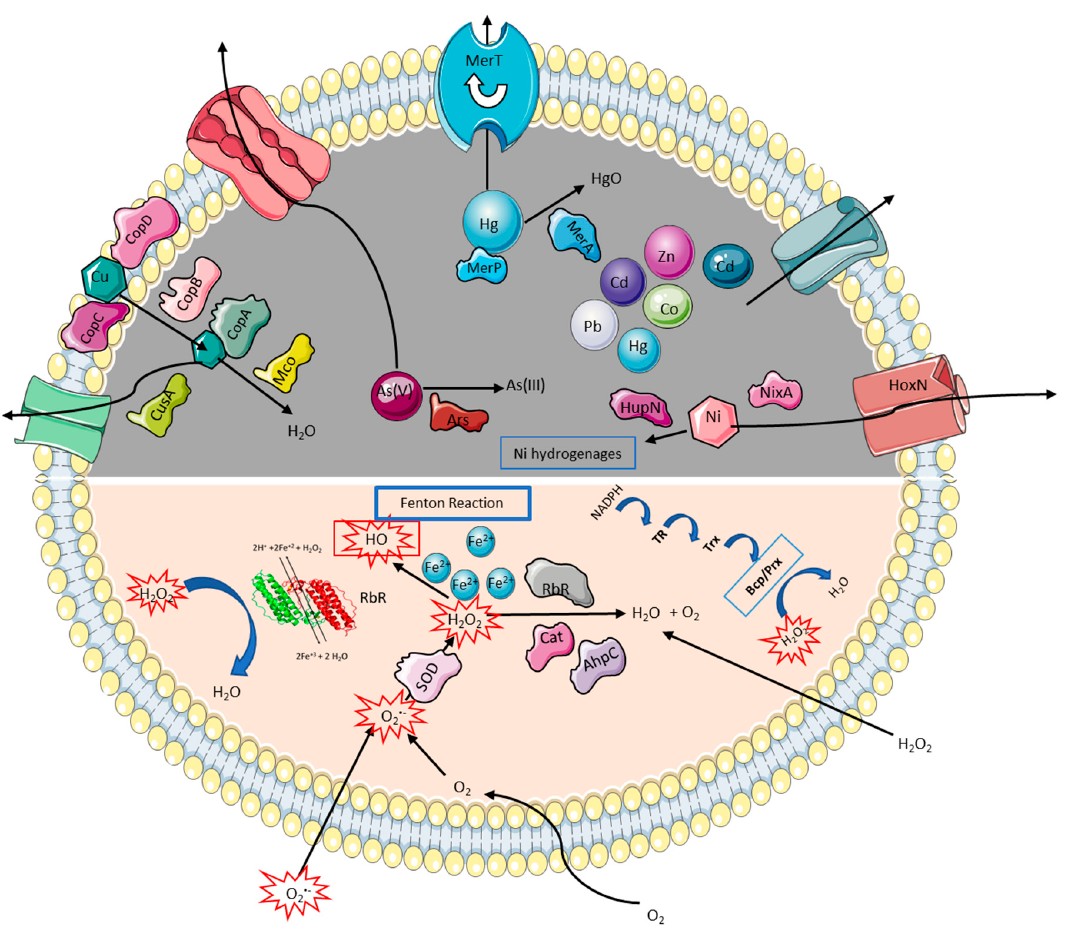
Figure 4. General model of metal (dark gray shading) and oxidative stress (pink shading) tolerance mechanisms used by all members of the Acidihalobacter genus. Alkyl hydroperoxide reductase subunit C (AhpC); arsenic resistance protein (Ars); bcp-type peroxiredoxin (BCP/Prx); catalase (Cat); copper translocating P-type ATPase (copA); copper-resistance protein B (CopB); copper-resistance protein C (CopC); copper-resistance protein D (CopD); high-affinity nickel transport protein (HoxN); hydrogenase nickel incorporation protein (HupN); high-affinity nickel-transport protein (NixA); mercuric reductase (MerA); mercury scavenging/binding (MerP); mercury transporting protein (MerT;) multicopper oxidase (Mco); rubrerythrin (Rbr); superoxide dismutase (SOD); thioredoxin (Trx); thioredoxin reductase (TR).